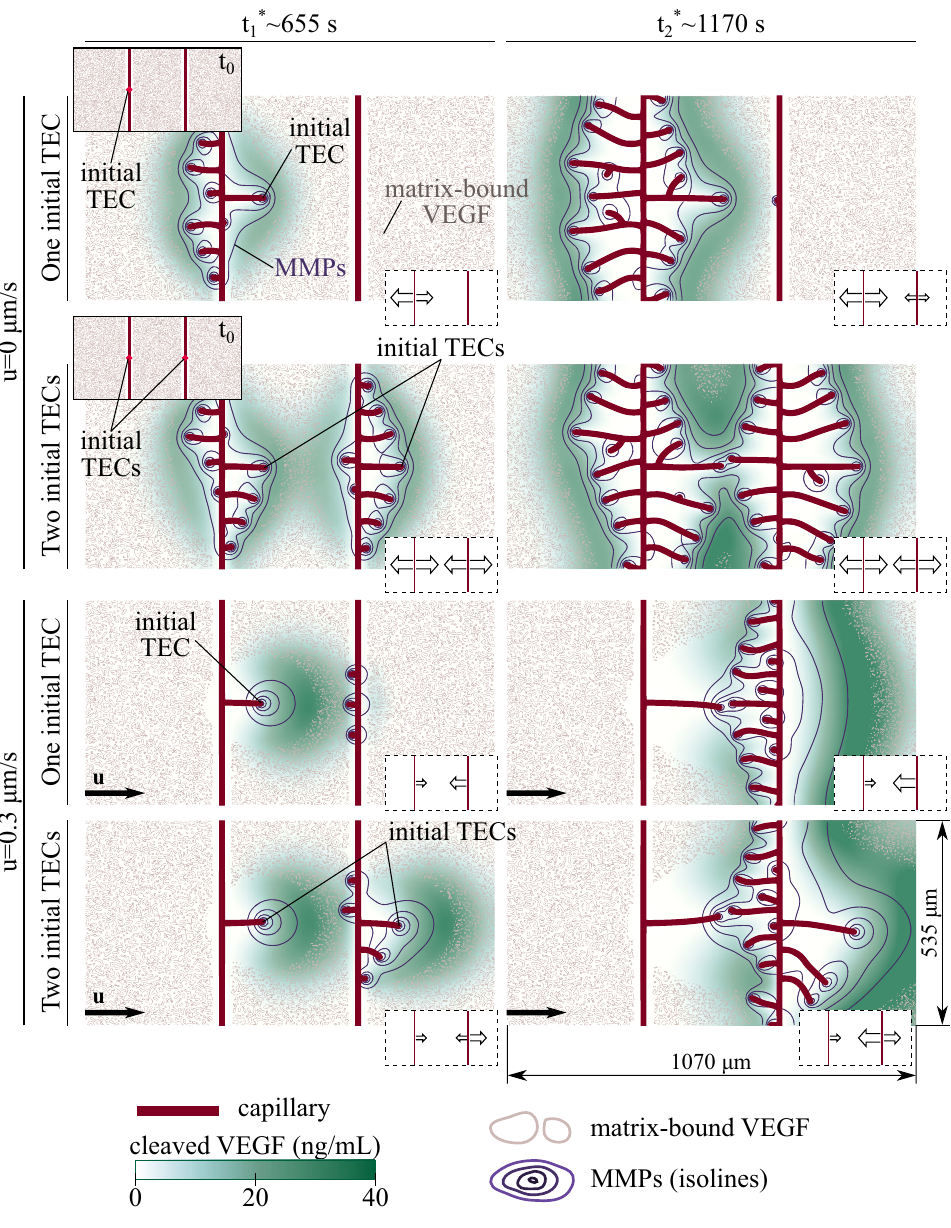
Figure 3. Angiogenesis controlled by matrix-bound chemokines in a two-parent vessel configuration. No-flow − 1 (upper half) and flow-mediated ( u = 0.3 µ m s , bottom half) angiogenesis for initial conditions with one tip cell in the left parent vessel (first and third rows) and tip cells in both parent vessels (second and fourth rows). The two solid-line insets show the two initial configurations. Capillary network (red), cleaved-VEGF distribution (green), MMPs isolines (purple), and matrix-bound VEGF contour lines (gray) at two different ∗ i = 1 or 2) does not represent the same time for the four simulations, but similar times. Note the time t i (where times. The dashed-line inset at the bottom-right corner of each panel indicates the direction and degree of vascular growth ( averaged over several simulations, the size of the arrows is proportional to the number of growing